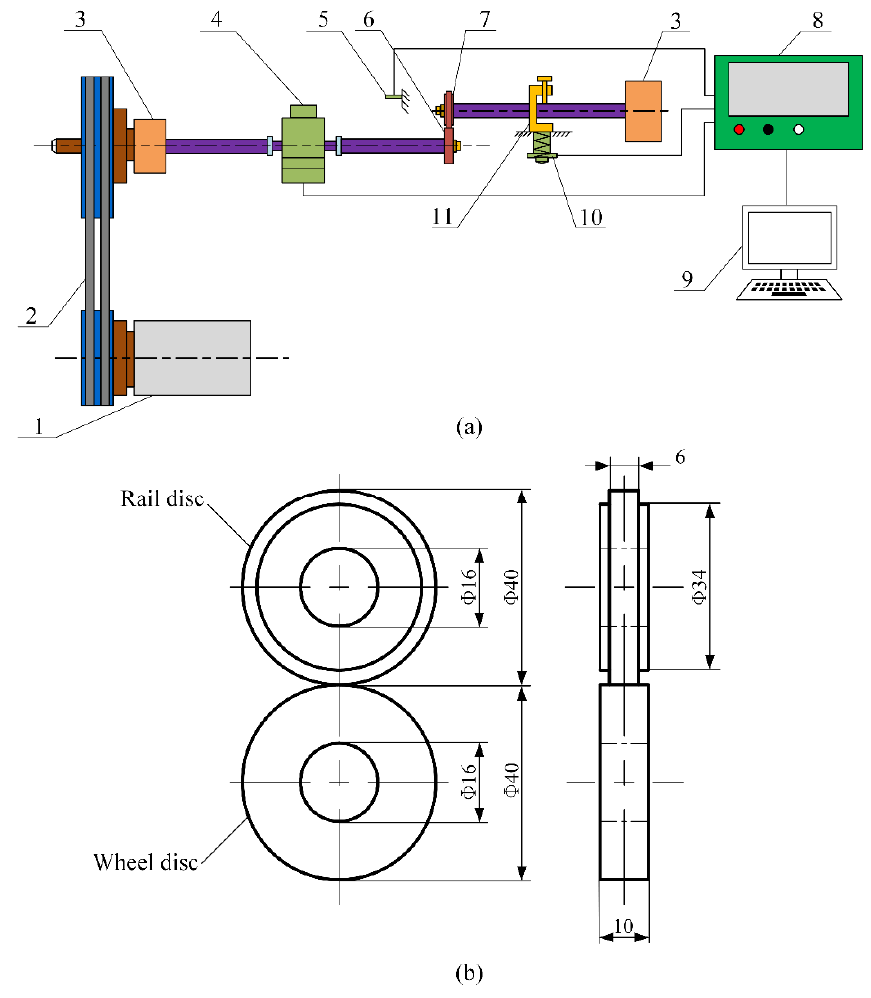
Figure 5. Experimental setup for the rolling-sliding tests. ( a ) Schematic illustration of the testing apparatus. 1, DC motor; 2, driving belt; 3, gearbox; 4, torque transducer; 5, rotational speed transducer; 6, lower roller; 7, upper roller; 8, controller; 9, computer; 10, load transducer; 11, compression spring. ( b ) Configuration and geometric size of the wheel/rail discs (unit: mm).